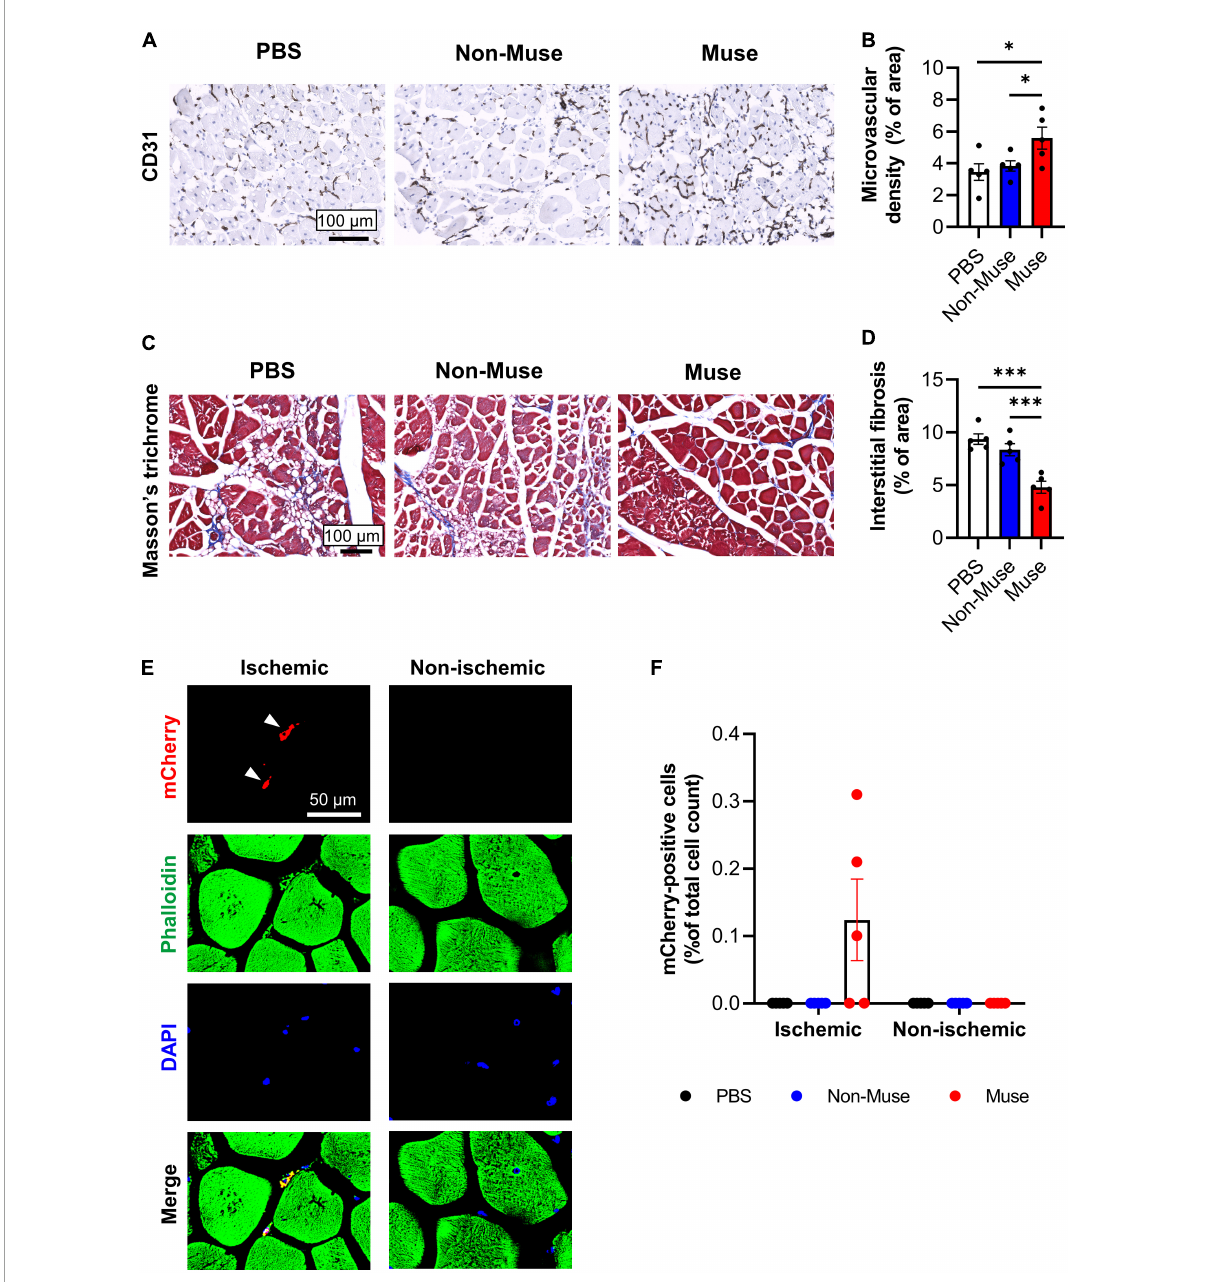
FIGURE2 Muse cells enhanced angiogenesis and ameliorated muscle fibrosis in ischemic hindlimb. (A) Representative images of microvascular density in ischemic adductor muscles at 14 days after hindlimb ischemia (HLI) surgery. Tissue sections were stained with anti-CD31 antibody and detected with DAB (brown). Scale bar, 100 µ m. (B) Quantitative analysis of the CD31-positive vessel area. Results are expressed as mean ± SEM ( n = 5). Dots correspond to each mouse. ∗ P < 0.05. (C) Representative images showing muscle fibrosis in the ischemic adductor muscles at 14 days after HLI surgery. Tissue sections were stained with Masson’s trichrome (blue = collagen fibers; red = muscle). Scale bar, 100 µ m. (D) Quantitative analysis of the fibrotic area in Masson’s trichrome-stained ischemic adductor muscles. Results are expressed as mean ± SEM ( n = 5). Dots correspond to each mouse. ∗∗∗ P < 0.001. (E) Representative images of ischemic and non-ischemic adductor muscle at 7 days after HLI surgery. Muse cells expressing mCherry were intravenously administered 1 day after HLI surgery. Tissue sections were stained with phalloidin (green) and DAPI (blue). White arrowheads indicate mCherry-expressing Muse cells in the ischemic border zone of the ischemic adductor muscle. Scale bar, 50 µ m. (F) Detection of Muse cells in the adductor muscles by flow cytometry at 7 days after HLI surgery. Human mCherry-expressing Muse cells, non-Muse MSCs were intravenously administered 1 day after HLI surgery and PBS was injected as a control ( n = 5 per each group). Results are expressed as mean ± SEM of the percentage of mCherry-positive cells per total cell count in the dissociated ischemic adductor muscle. Dots correspond to each